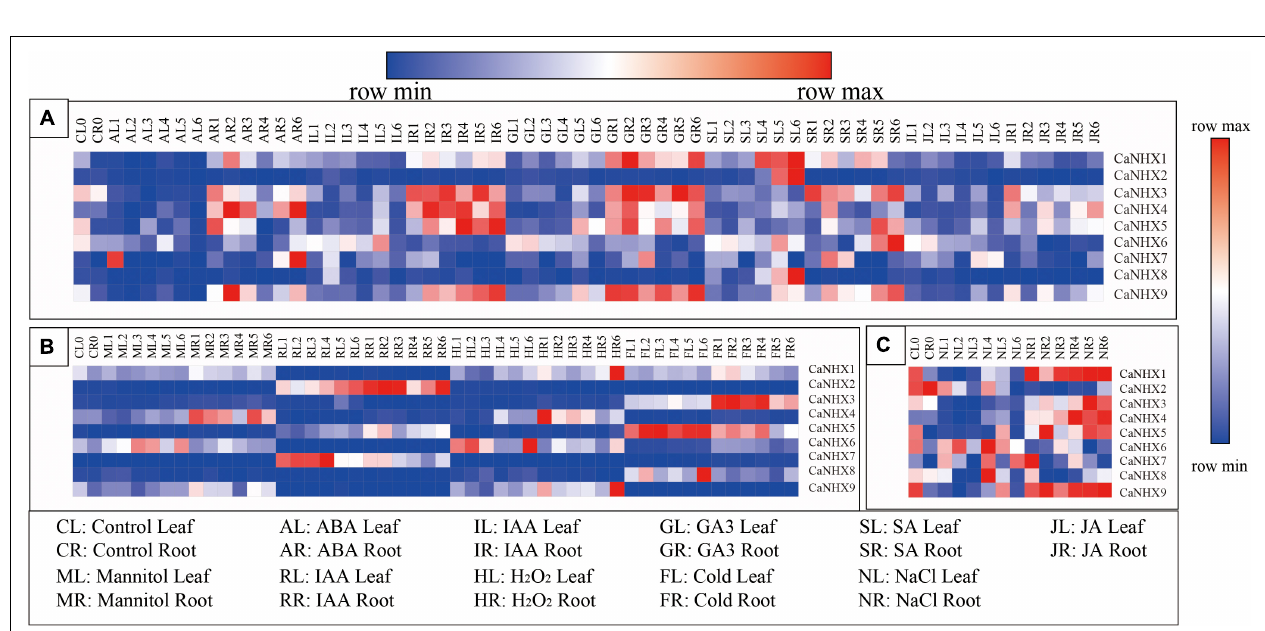
Frontiers in Genetics |